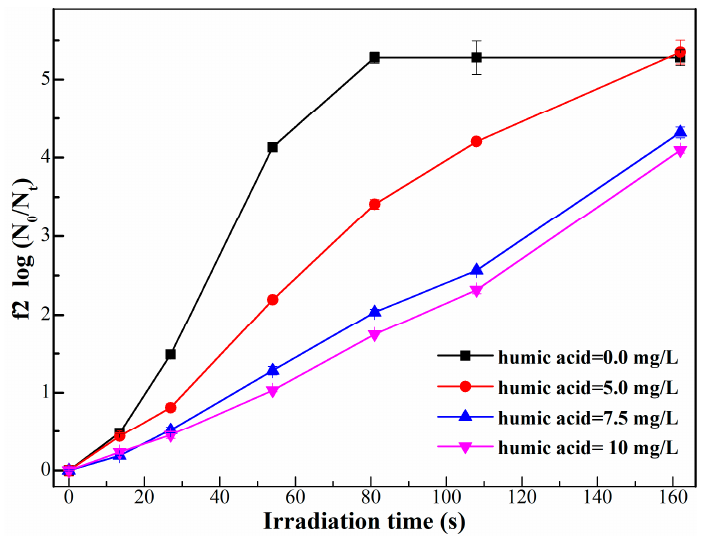
Figure 4. The effect of different concentrations of humic acid on photocatalytic disinfection of phage f2 by TiO 2 -P25.